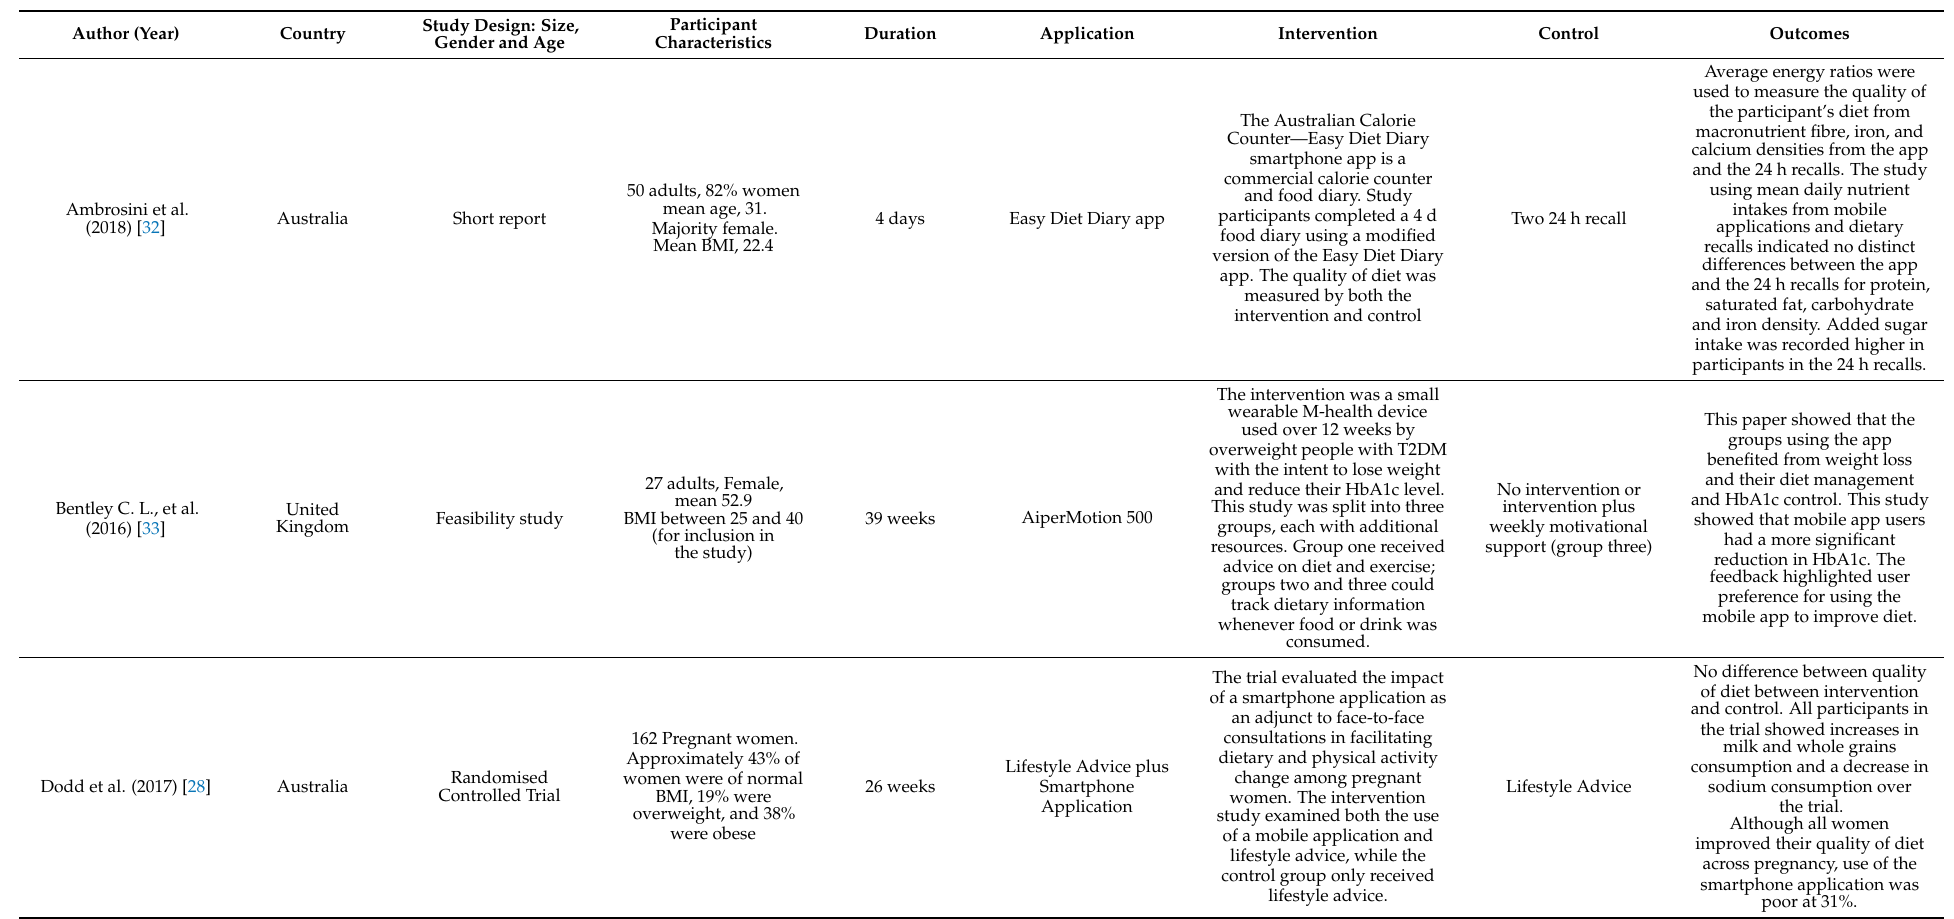
Table 1. Summary of study characteristics for included